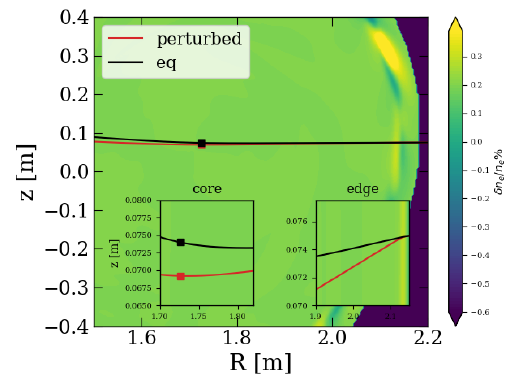
Figure 11. 2D density contour plot with density perturbation at the edge used in the forward model. The ECE ray is refracted at the edge which can be seen in the zoomed picture and the resonance (in red) is displaced with respect to the equilibrium (black)